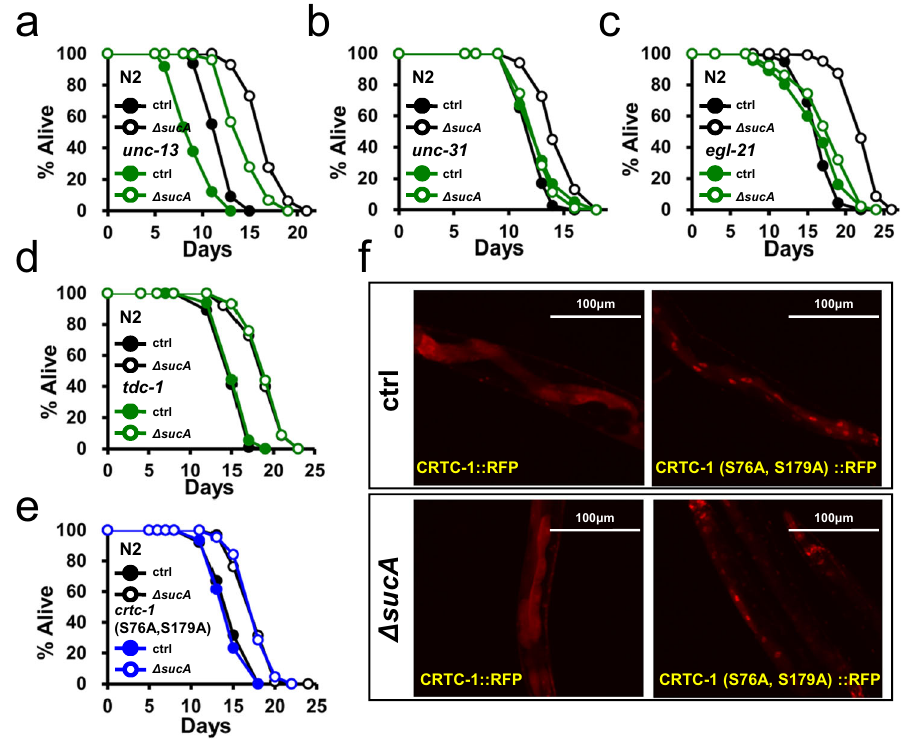
Fig. 5 | GR promotes longevity non-cell autonomously via pro-longevity neu- ropeptide. a Lifespan showing that GR diets extend lifespan of unc-13 (e51) ( P <1.0×10 − 10 , P value determined by two-tailed Student ’ s t test). Results from one of three biological independent experiments are shown. b Lifespan showing that GR diets fail to extend lifespan of unc-31(e928) ( P =0.3647, P value determined by two-tailed Student ’ s t test). Results from one of three biological independent experiments are shown. c Lifespan showing that GR-induced longevity is sig- ni fi cantly shortened in egl-21(n476) animals ( P =0.006, P value determined by two- tailed Student ’ s t test). Results from one of three biological